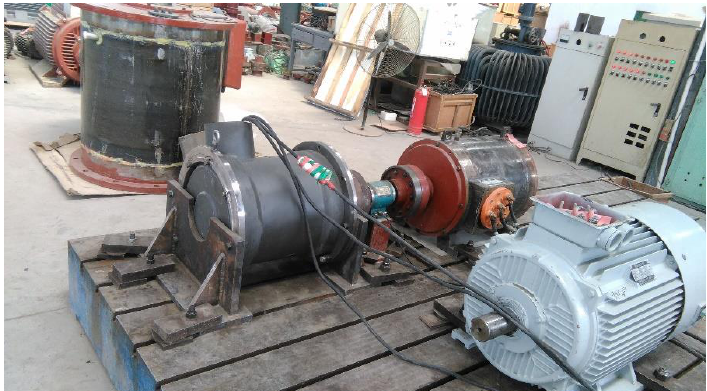
Figure 5. Generator performance test device.